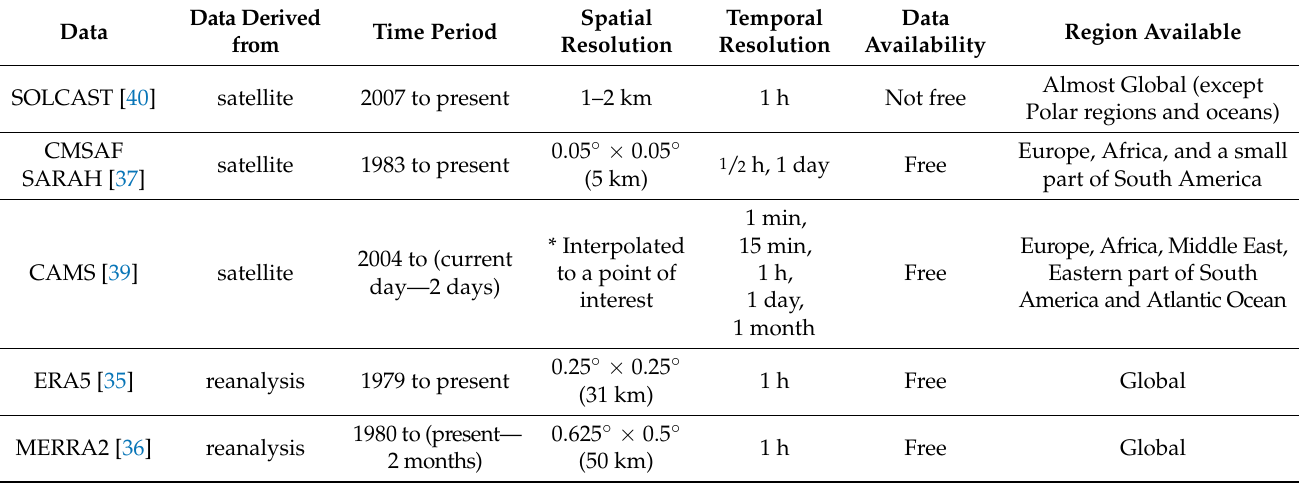
Table 4. Summary of the satellite-based and reanalysis based